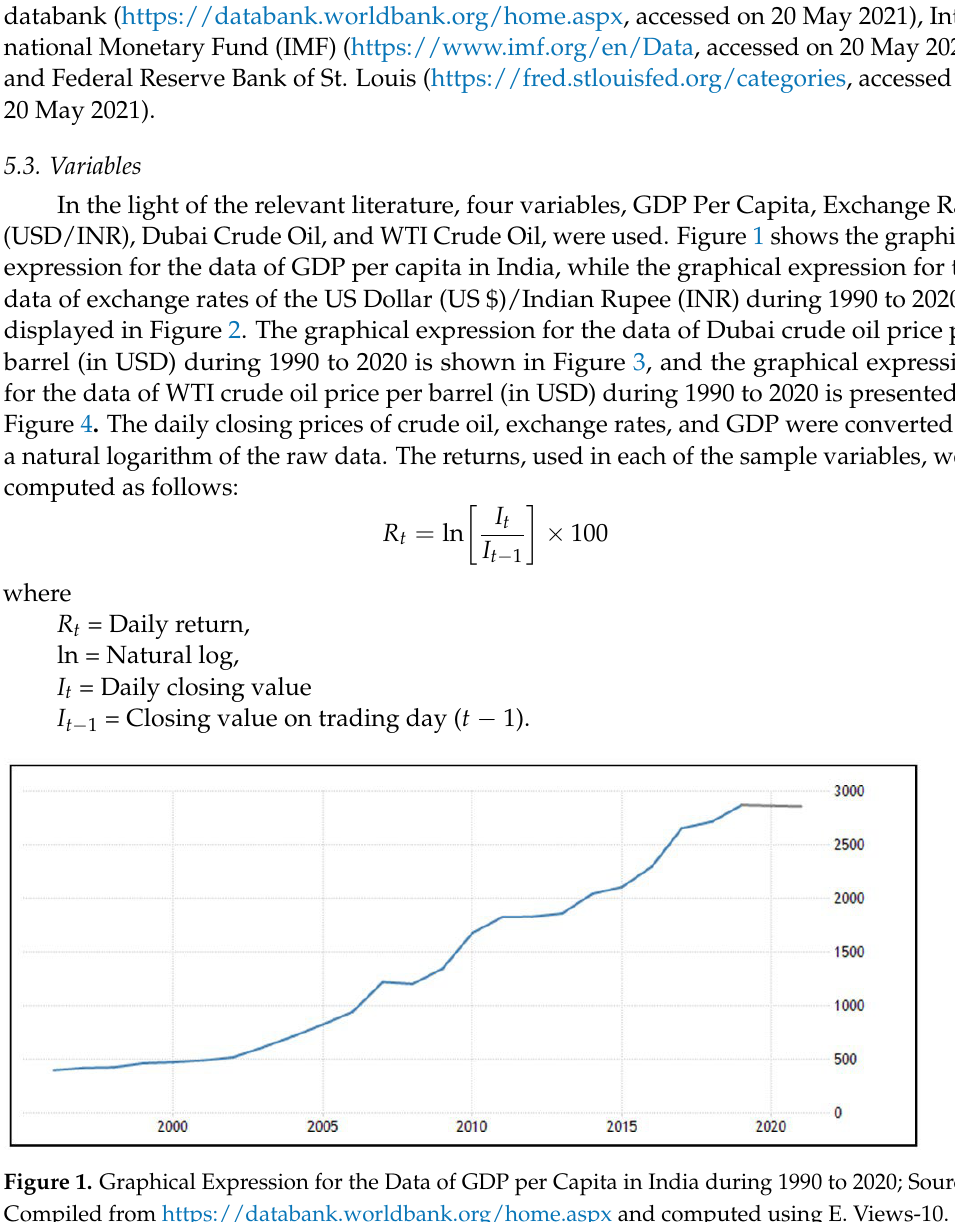
Figure 2. Graphical Expression for the Data of Exchange Rates of US Dollar (US $)/Indian Rupee (INR) during 1990 to 2020; Sources: Compiled from https://www.imf.org/en/Data and computed using E-Views-10. Figure 3. Graphical Expression for the Data of Dubai Crude oil Price per barrel (in USD) during 1990 to 2020; Sources: Compiled from https://fred.stlouisfed.org/categoriesa (accessed on 20 May 2021) and computed using E. Views-10.